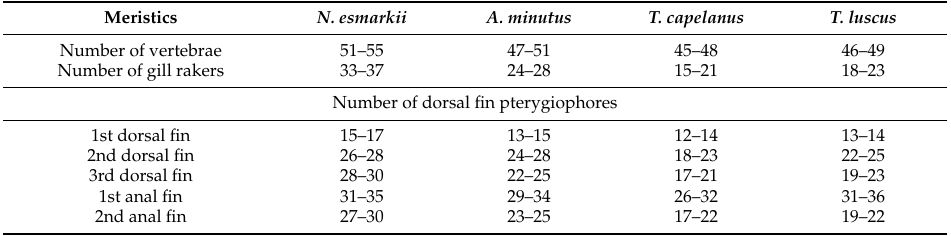
Table 5. Meristics showing the intermediate position of Allotrisopterus minutus between Neocolliolus and Trisopterus (after reference [20]); numbers of vertebrae and gill rakers supplemented with data given in [1,2]. Meristics N.